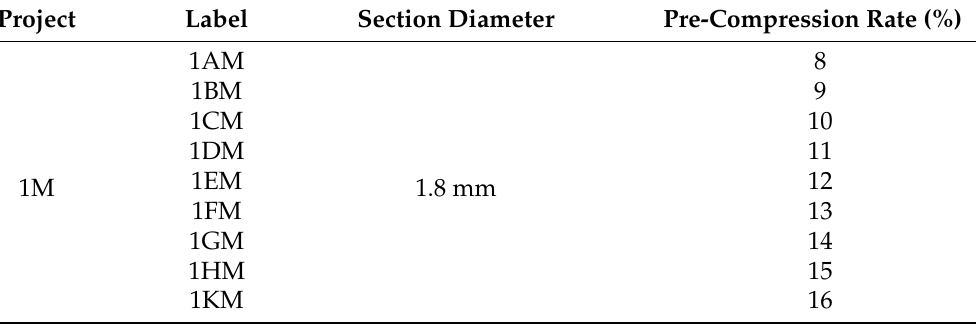
Table A3. Parameters and labels of pre-compression rate experiment.